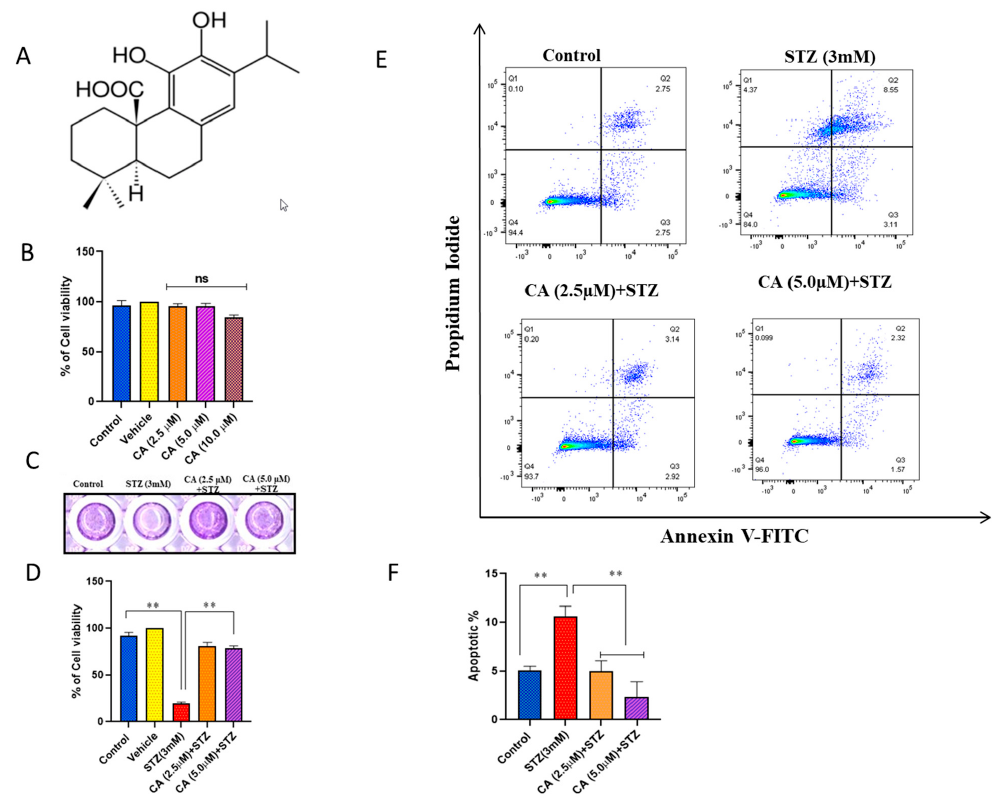
Figure 1. Impact of CA or STZ treatment on cell viability and apoptosis in INS-1 cells. ( A ) CA chemical structure. ( B ) MTT assay in INS-1 cells preincubated with various concentrations of CA (2.5, 5, 10 µ M) for 24 h compared to untreated cells. ( C ) Crystal violet staining for INS-1 cells. ( D ) MTT assay in STZ-treated cells (3 mM) or preincubated cells with 2.5 or 5 µM of CA for 24 h followed by STZ-treated versus untreated control cells. ( E ) Annexin V-PI analysis of apoptosis in untreated control cells, STZ-treated cells for 3 h, or cells pretreated with CA for 24 h prior to STZ exposure. Q1, Q2, Q3, and Q4 represent the necrotic, late apoptotic, early apoptotic, and viable cell populations. ( F ) Apoptotic index summarizes the apoptosis results. Data were obtained from three independent experiments. ** p < 0.01. Bars represent mean ± SD.